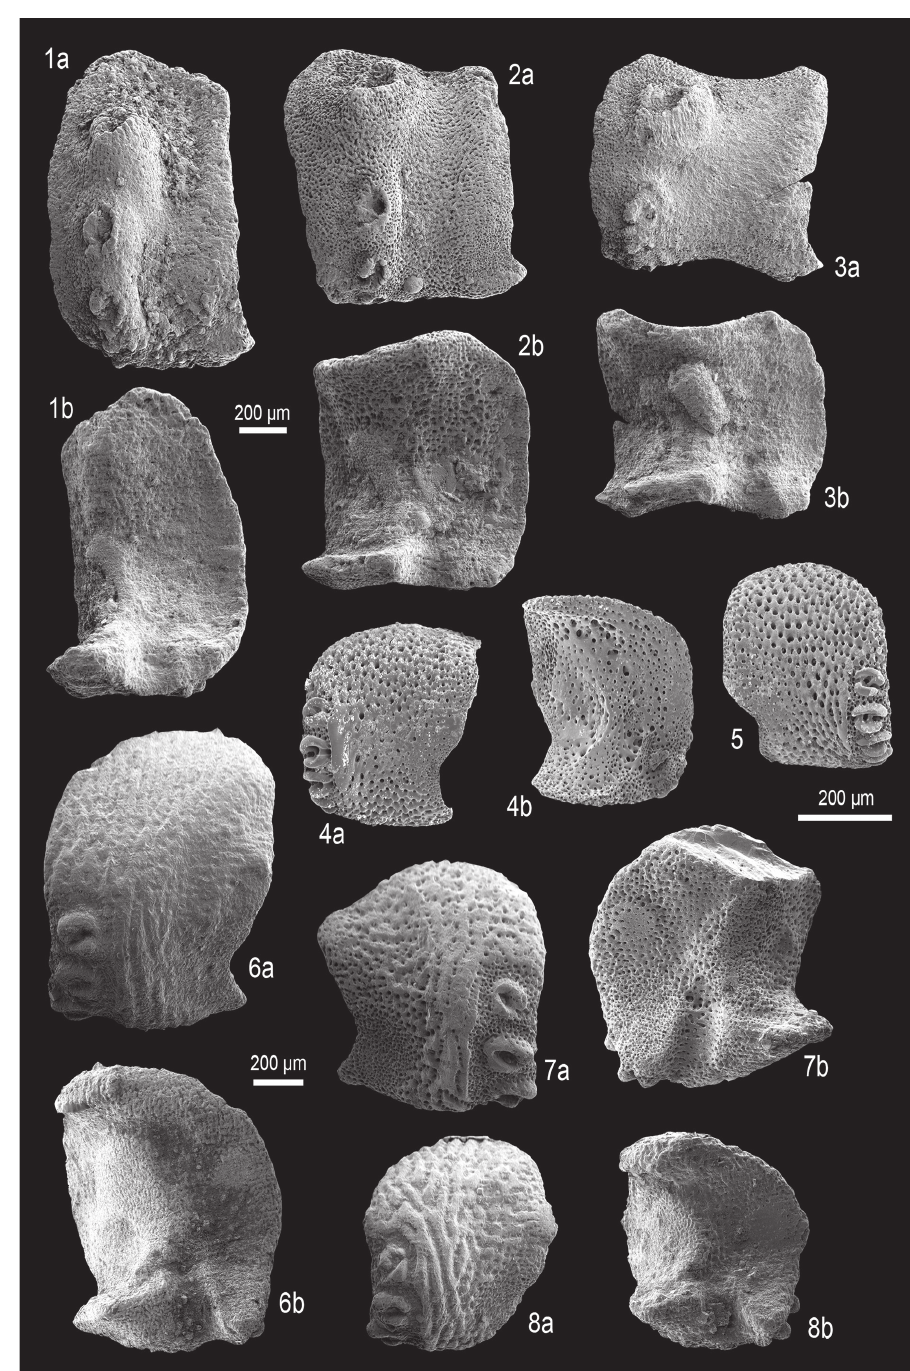
Fig. 36. Lateral arm plates (LAPs) of fossil and Recent ophiacanthid brittle stars in external (a) and internal (b) views. 1-3. Reitneracantha dissidens gen. et sp. nov. from the late Sinemurian to early Pliensbachian (Early Jurassic) of the Glasenbach Gorge, Austria. 1. NHMW 2012/0137/0029 (holotype), proximal LAP. 2. NHMW 2012/0137/0030 (paratype), median LAP. 3. NHMW 2012/0137/0031 (paratype), distal LAP. 4-5. Ophiohamus nanus O’Hara & Stöhr, 2006, Recent. 4. Proximal to median LAP. 5. Proximal to median LAP. 6-8. Sabinacantha archetypa gen. et sp. nov. from the late Oxfordian (Late Jurassic) of the Plettenberg, Germany. 6. GZG.INV.78771 (holotype), proximal LAP. 7. GZG.INV.78772 (paratype), median LAP. 8. GZG.INV.78773 (paratype), distal LAP. One common scale bar per